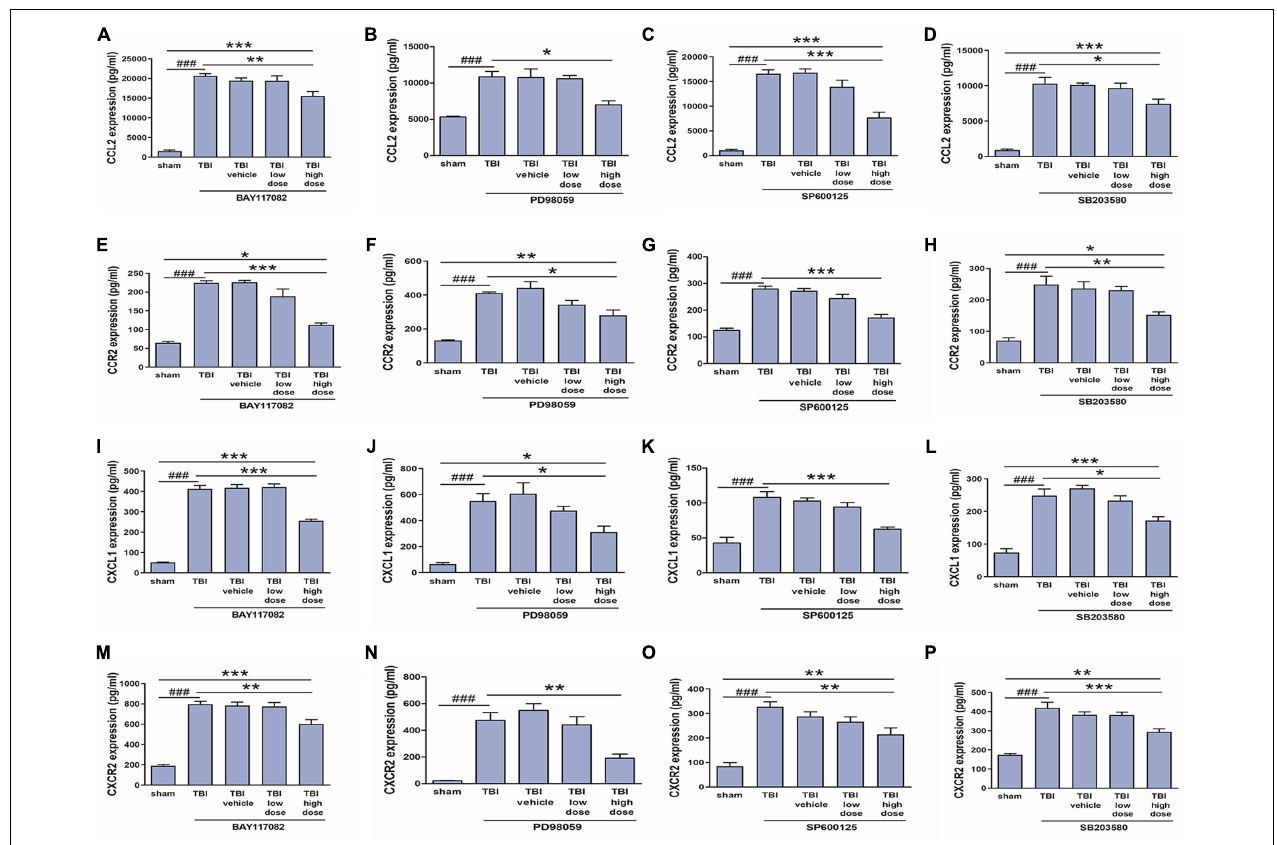
FIGURE 8 | Inhibitors of p-NF- κ B and MAPKs reduced upregulation of CCL2, CCR2, CXCL1, and CXCR2 following TBI. A 25 mg/10 ml dose of the p-NF- κ B inhibitor BAY117082, p-JNK inhibitor PD98059, p-ERK inhibitor SP600125, or p-p38 inhibitor SB203580 reduced CCL2 (A–D) , CCR2 (E–H) , CXCL1 (I–L) , and CXCR2 (M–P) protein expression in the injured cortex as measured by ELISA, while lower doses (2.5 mg/10 ml) had no significant effect. * P < 0.05, ** P < 0.01, and *** P < 0.001 vs. high dose group. ### P < 0.001 vs. sham group.